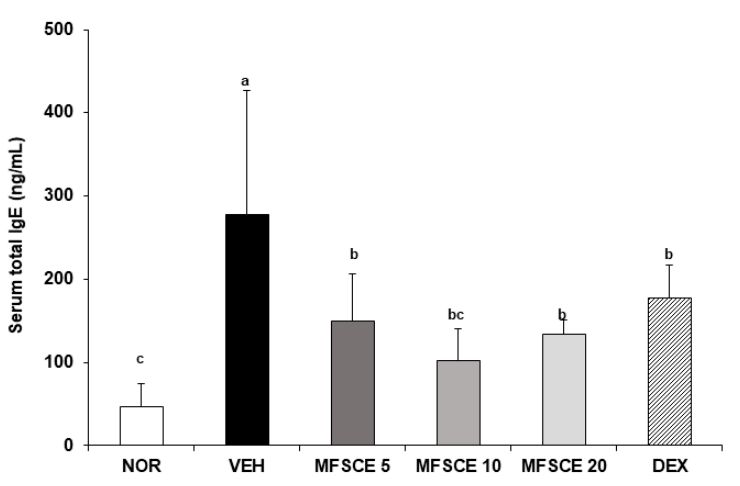
Figure 4. Effect of MFSCE on serum IgE increase in HDM-sensitized NC/Nga mice. Values are Figure 4. E ff ect of MFSCE on serum IgE increase in HDM-sensitized NC/Nga mice. Values are mean mean ± SD. a–c Means with different letters are significantly different ( p < 0.05) as determined by ± SD. a–c Means with di ff erent le tt ers are signi fi cantly di ff erent ( p < 0.05) as determined by Duncan’s Duncan’s multiple range test. The mice were grouped and treated as described in Figure multiple range test. The mice were grouped and treated as described in Figure 2.